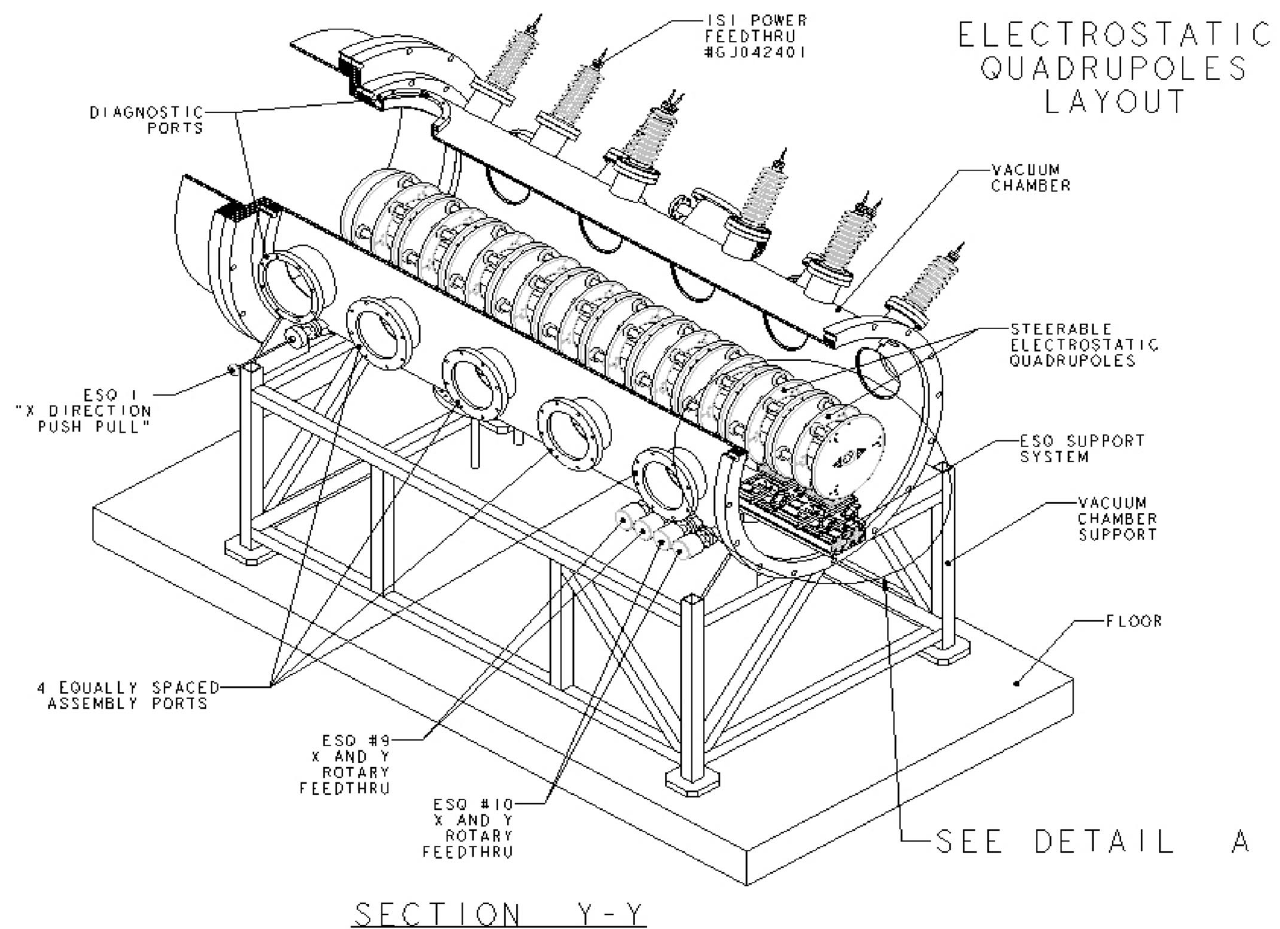
FIG. 5. Cutaway view of the electrostatic transport